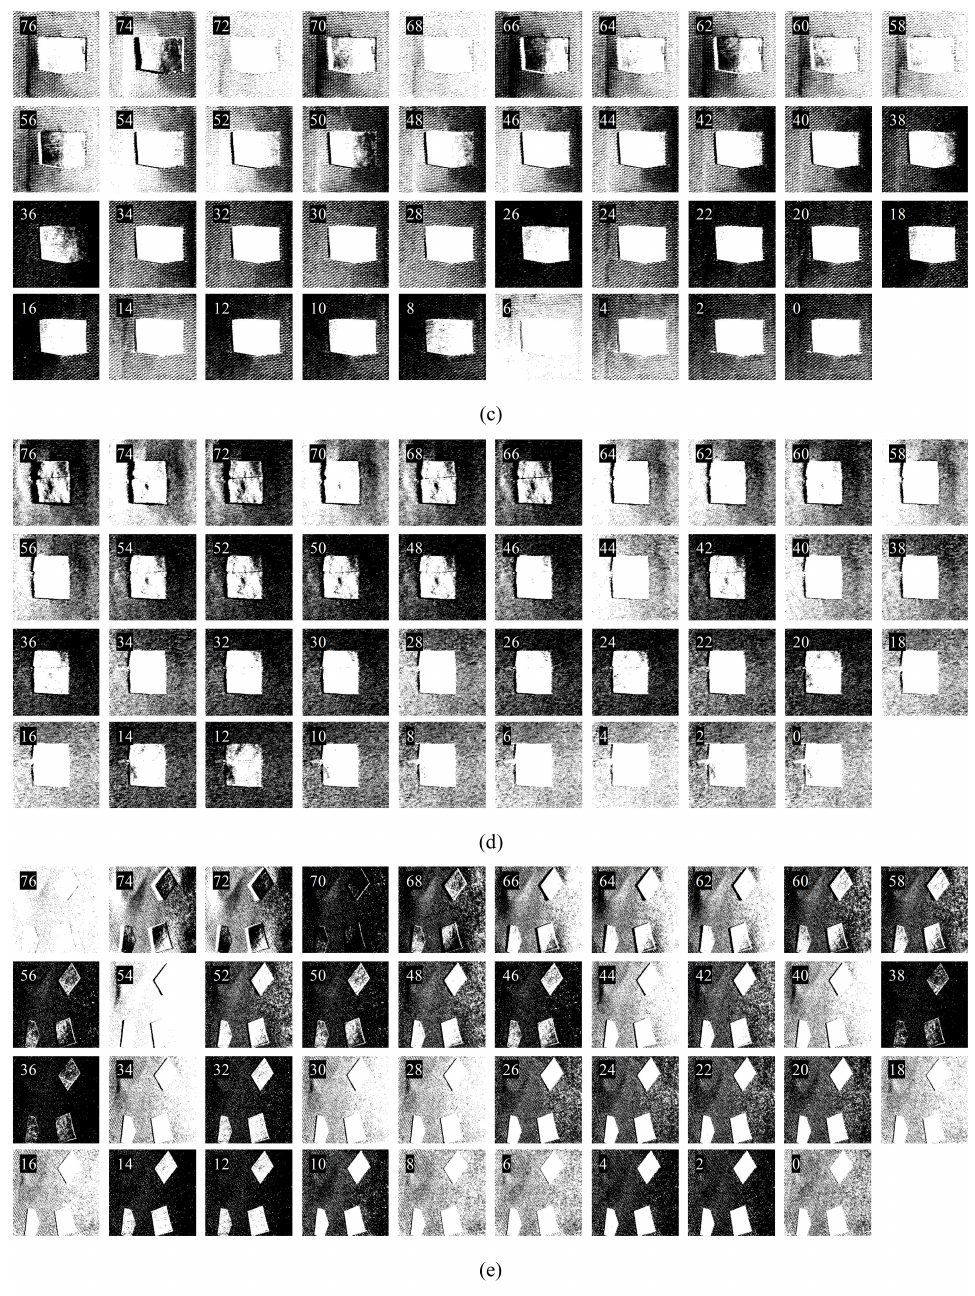
Figure 10. Diagram of the segmentation result images obtained by Method 2: ( a ) Group 1; ( b ) Group 2; ( c ) Group 3; ( d ) Group 4; ( e ) Group 5. Note that the incident angles of light are marked on the